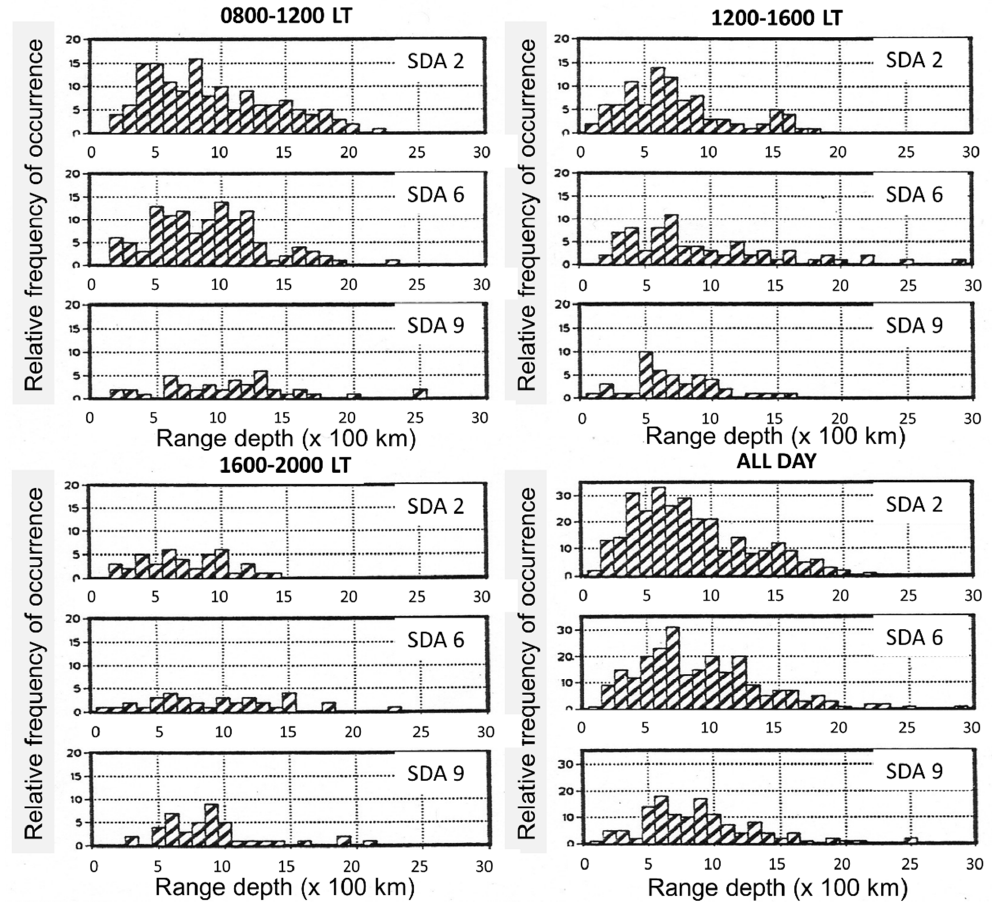
Figure 22. Distributions of data quality against instantaneous range depth for different periods of the day.